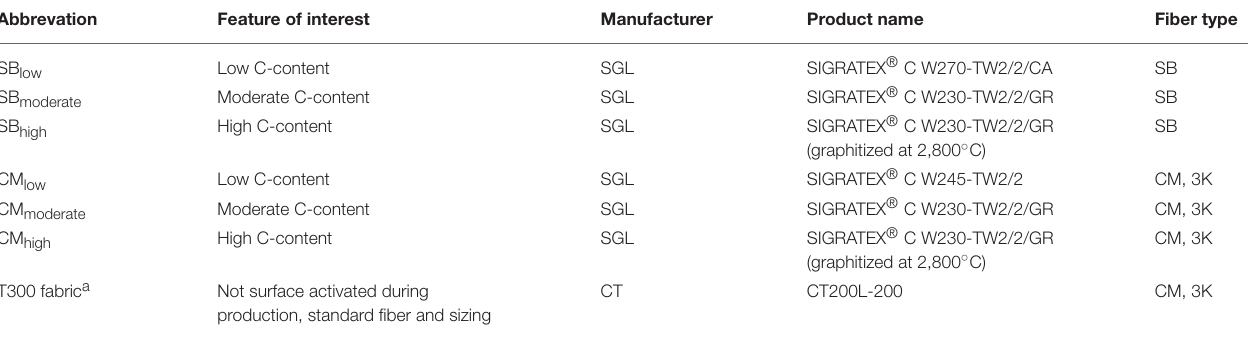
TABLE 2 | CF fabrics used in this